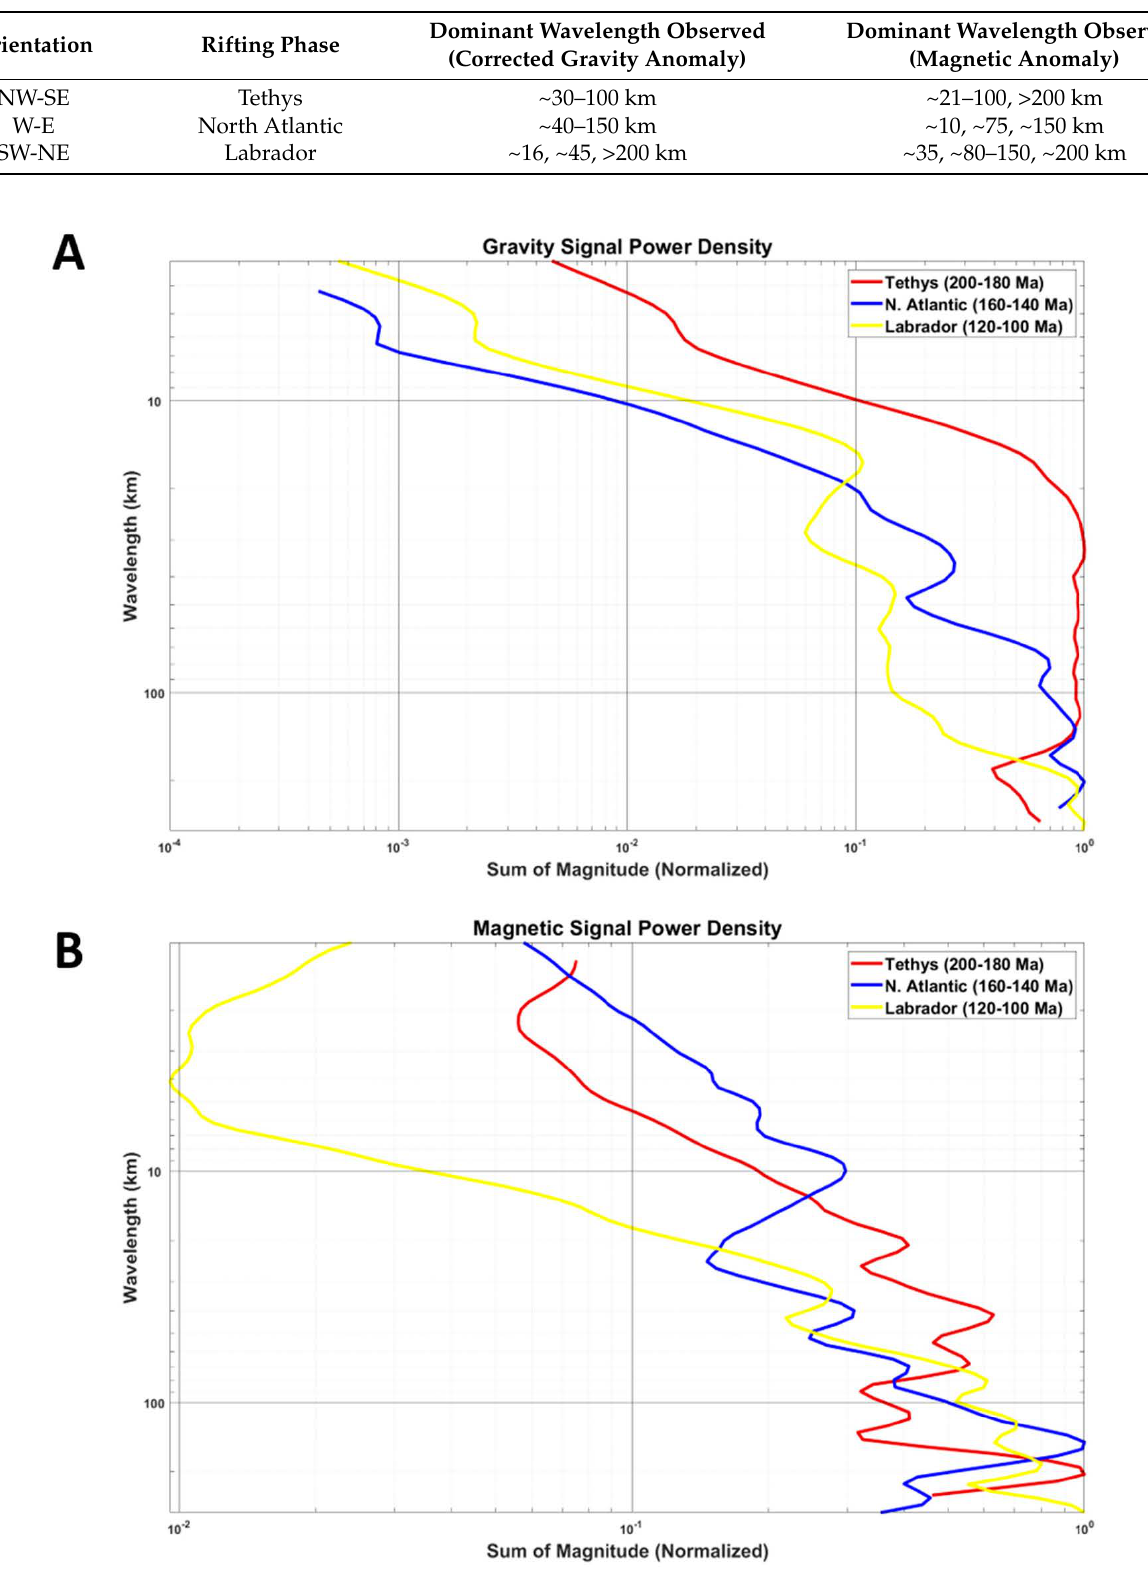
Figure 8. Spectral signatures of uncorrected free air gravity ( A ) and magnetic anomaly ( B ) data along transects corresponding to each rift phase, indicated in Figure 7 (dashed